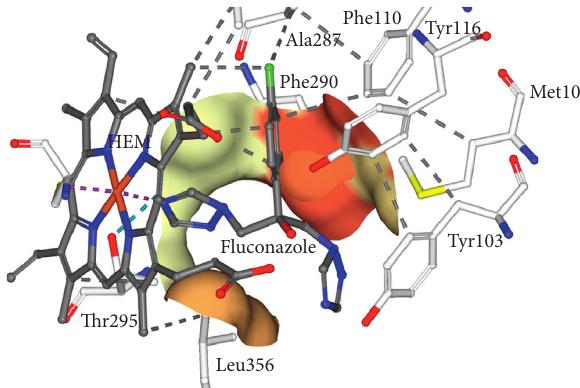
Figure 1: Fluconazole bound to T. cruzi- CYP51